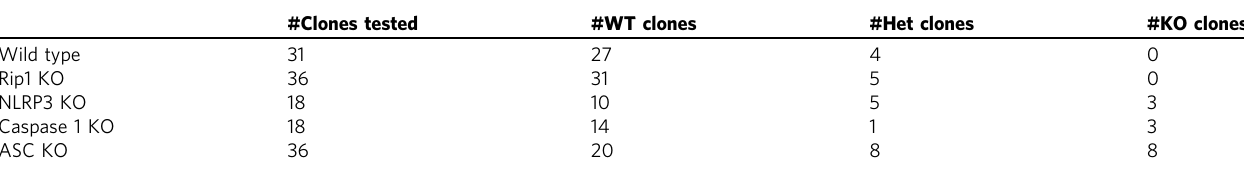
Table 1 Wnk1 knockout is lethal in immortalized macrophages with fully functional NLRP3 in fl ammasome